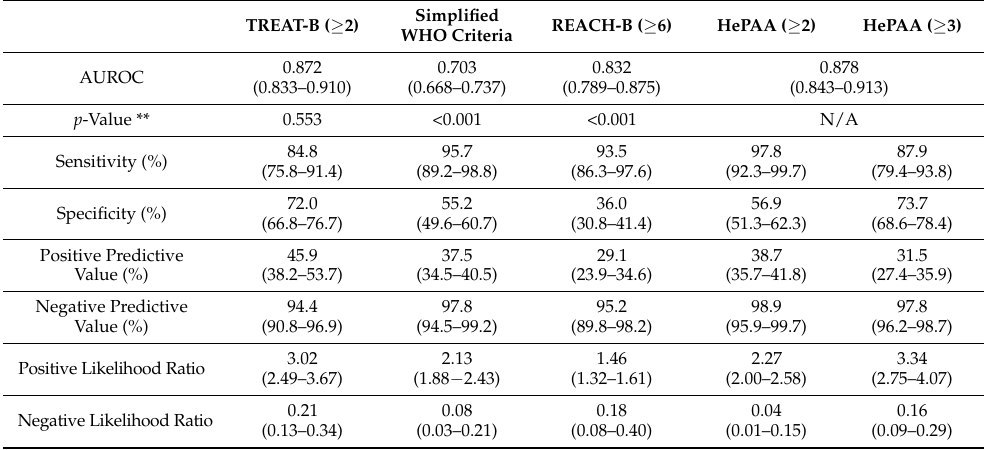
Figure 1. Receiver operating characteristic curves for the HePAA, TREAT-B, and REACH-B scoring systems and the WHO simplified criteria for indicating EASL treatment eligibility in the derivation ( n = 602) and validation cohorts ( n = 420). EASL, European Association for the Study of the Liver; REACH-B, Risk Estimation for Hepatocellular Carcinoma in Chronic Hepatitis B; TREAT-B, Treatment Eligibility in Africa for the Hepatitis B Virus; WHO, World Health Organization. Table 5. The performance of various systems in determining chronic hepatitis B treatment eligibility, according to EASL guidelines, in the validation cohort ( n =